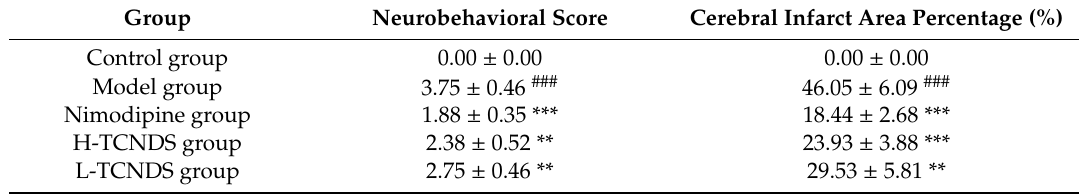
Table 1. The results of neurobehavioral performance score and cerebral infarct area ( x ± s, n = 8).